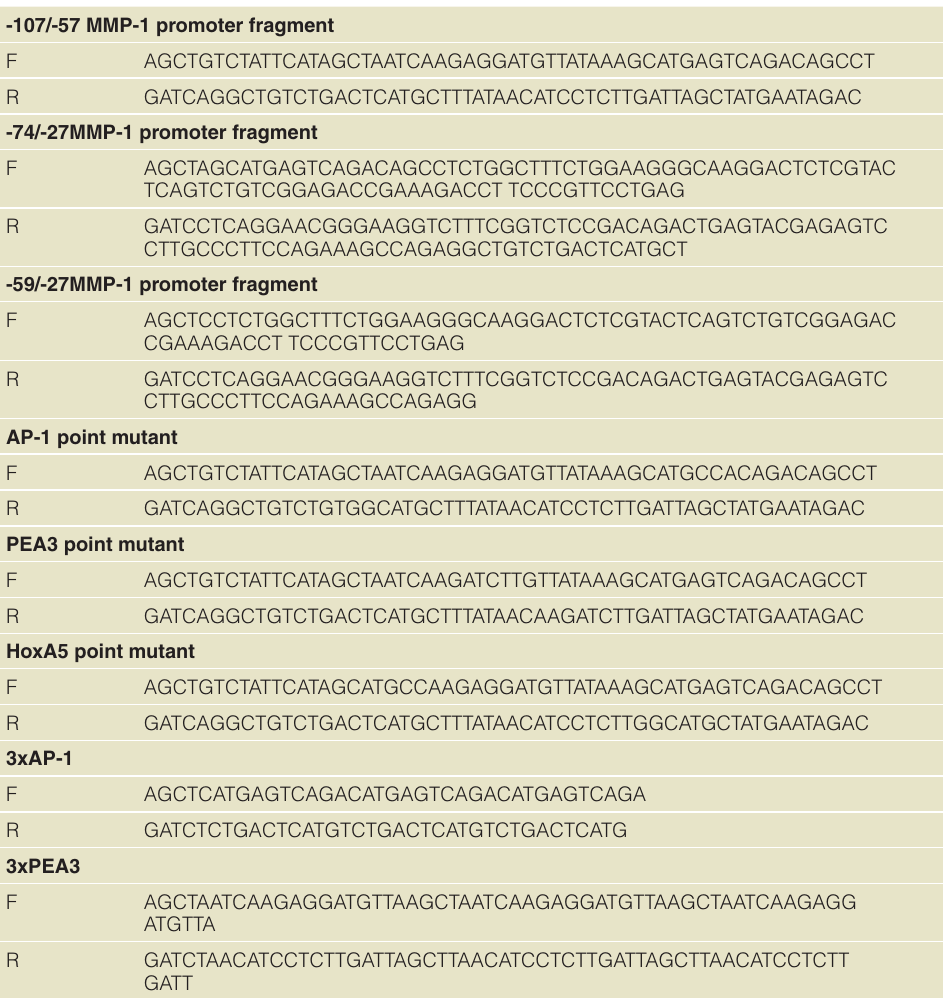
Table 2. Oligonucleotide sequences used to construct luciferase reporter genes. The indicated forward and reverse oligonucleotides for MMP-1 promoter fragments were annealed and cloned upstream of the c-Fos minimal promoter in a pGL3 Basic backbone. The AP1, PEA3 and HoxA5 point mutants were made in the -107/-57 fragment. The 3xAP1 and 3xPEA3 sites were cloned upstream of the c-Fos minimal